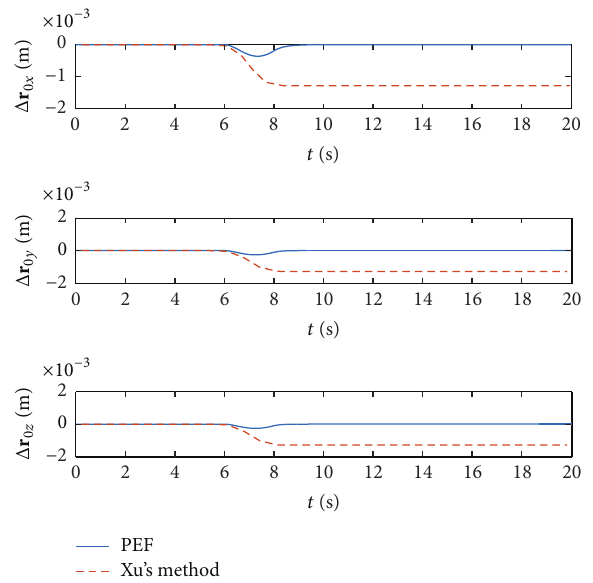
Figure 6: The linear and angular velocities of the disturbed base.